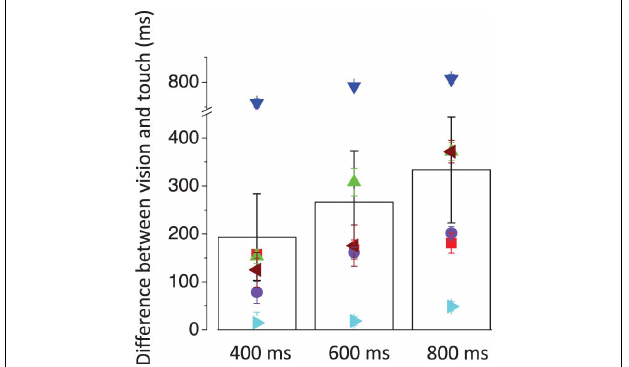
FIGURE 3 | Difference between the reproduced durations for the visual and tactile stimuli as a function of stimulus duration. The symbols represent the individual data and the bars represent the averages across subjects.